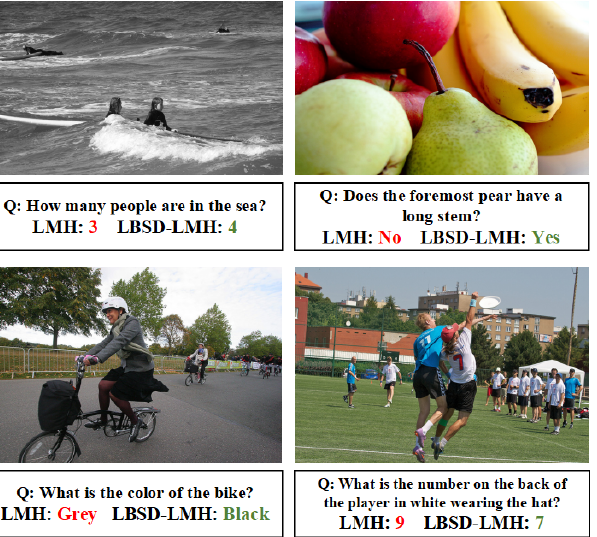
Figure 5. Qualitative examples of VQA-CP v2 (test set). The wrong and right answers are highlighted in red and